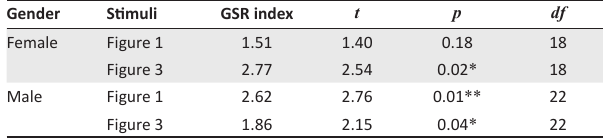
TABLE 4: Galvanic skin response results: Text.